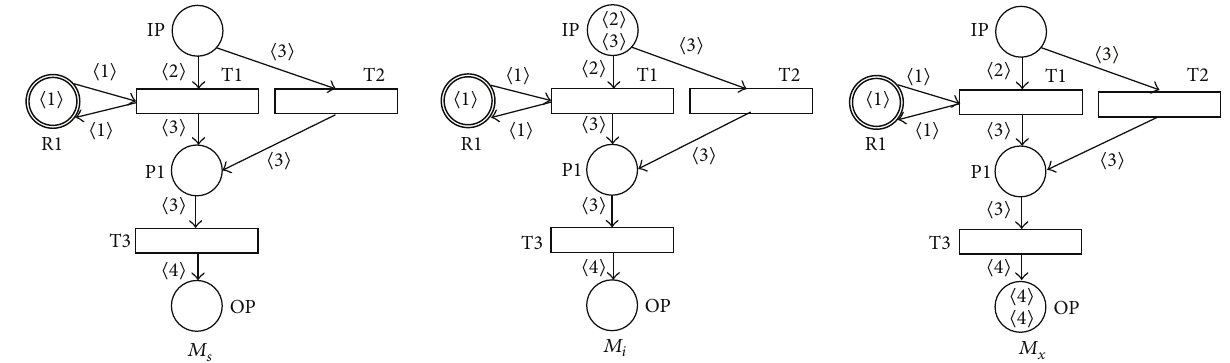
Figure 3: Static, input, and output markings of the SNT process net 𝑁3